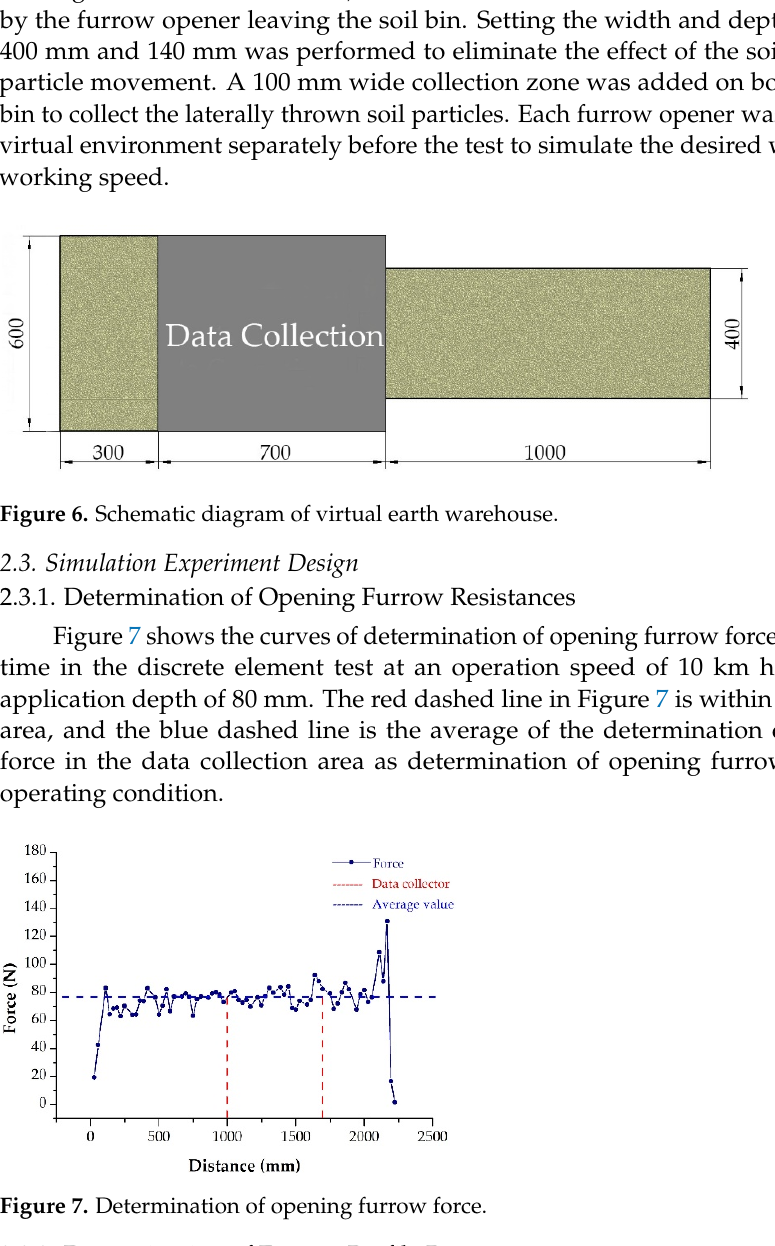
Figure 8. Construction of furrow profile by porosity grid. After extracting the furrow profile, the parameters of A 1 , A 2 , A 1 + A 2, Furrow backfill, Furrow width, Lateral soil throw and Furrow spill over could be extracted, as shown in Figure 9. Furrow backfill and Furrow spill over are defined by Equations (2) and (3) respectively.